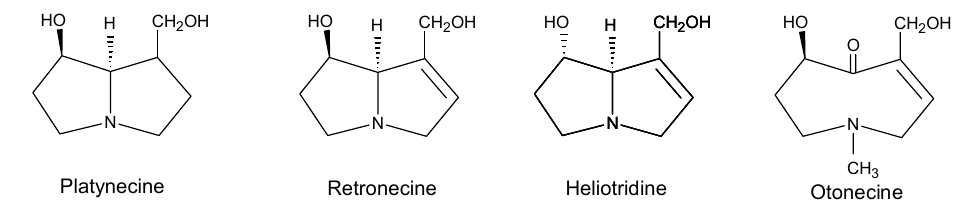
Figure 1. Common necine bases of pyrrolizidine